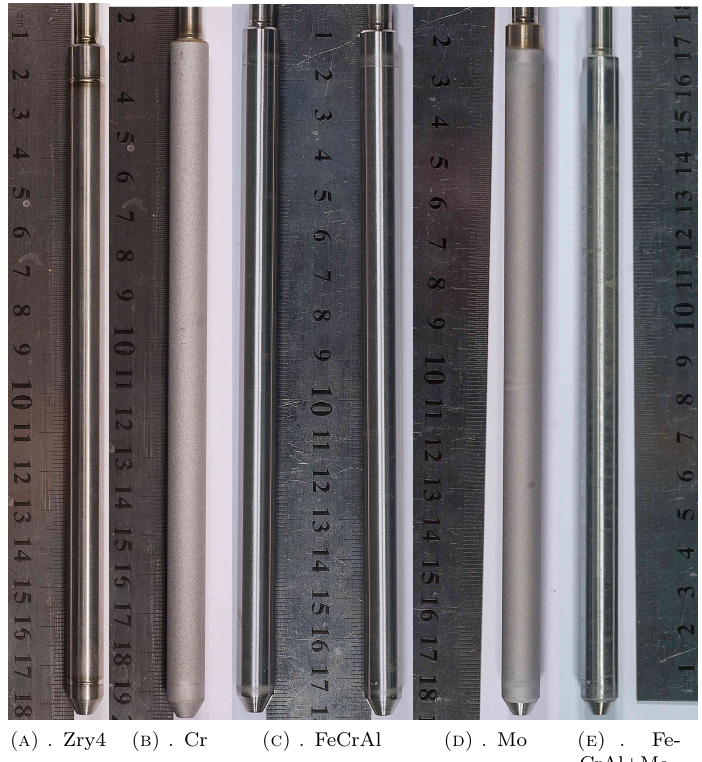
Figure 2. Pressure tubes for creep experiments in as-coated state. Cr-coated tube is fully coated including the welds and the end cap, the other coatings cover linear part of tubes